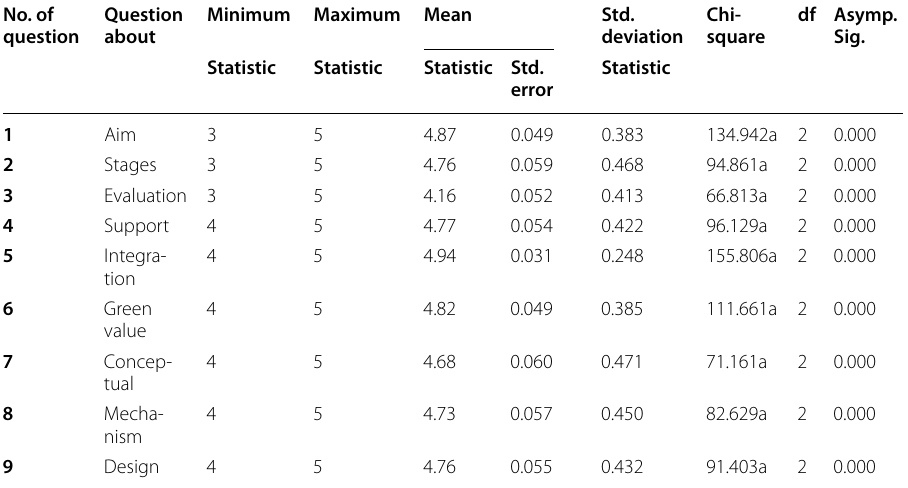
Table 7 The descriptive statistics and chi-square test of the practical survey results of the questionnaires were computed by